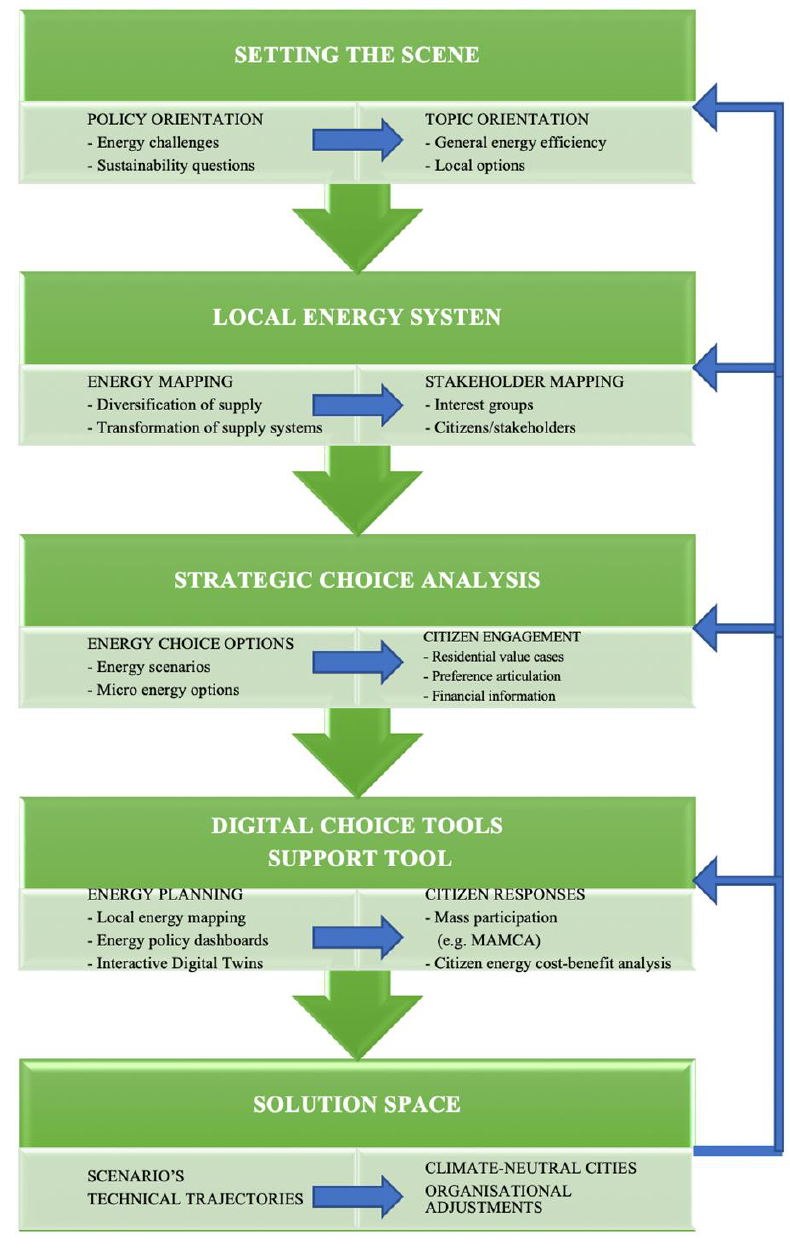
Figure 4. The energy transition framework.